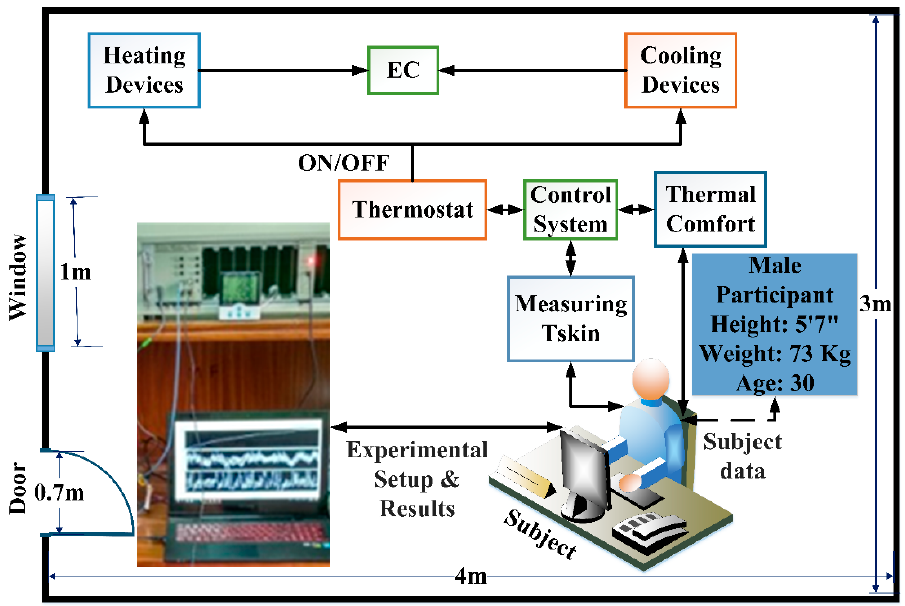
Figure 13. The schematic diagram of the experimental setup with subject specifications and room dimensions.